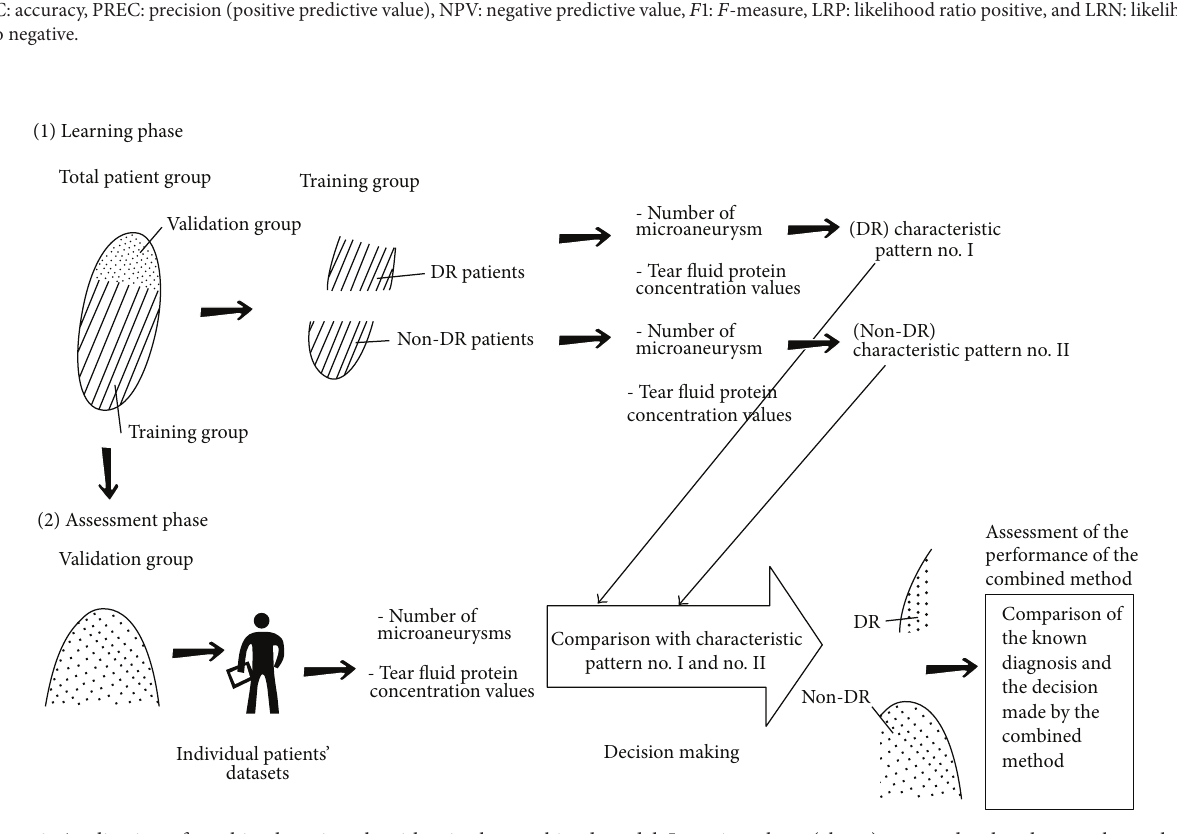
Figure 2: Application of machine learning algorithm in the combined model. Learning phase (above): we randomly select a subpopulation of the total patient group, called the training group, and then use the known clinical diagnosis to split the training group into a DR group and a non-DR group. The clinical diagnosis, the number of MAs on the retina images, and the protein concentration values are the inputs of the machine learning algorithm. The algorithms are able to tell which data patterns are the most characteristic for the DR and